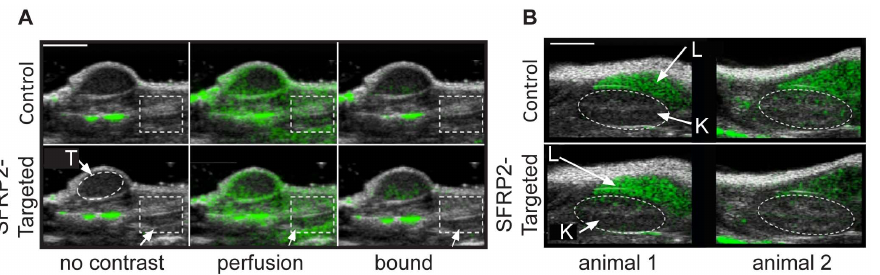
Figure 4. Modified microbubble contrast agents were not retained at significant levels in nonmalignant vasculature. B-mode images (black and white) are shown overlaid with CPS-mode images (green). CPS-mode is sensitive to ultrasound signal typically produced by microbubbles oscillating within an ultrasound field. (A) In the absence of ultrasound contrast agent (no contrast) there was no CPS-mode signal within the region of interest (dotted rectangle) outside of the tumor margins. Tissue artifacts generated the CPS-mode signal observed in the absence of contrast agent. Contrast agent freely flowing through both tumor and non-tumor vasculature generated CPS-mode signal throughout the field of view (panel A, perfusion, middle frames) with either streptavidin-coated (control, upper frames) or SFRP2- targeted ultrasound contrast agent (lower frames). No signal remained within the region of interest drawn outside of the tumor margins after allowing all freely flowing contrast agent to be cleared from the vasculature, while SFRP2 specific signal was retained within the tumor margins. (B) Modified microbubble contrast agents were not retained within kidney vasculature. Freely flowing streptavidin-loaded microbubbles (panel B, control, upper frames) or SFRP2 - targeted microbubbles (panel B, lower frames) were allowed to clear from the vasculature prior to three-dimensional molecular imaging. Single frames are shown from two different animals (animal 1 or animal 2). The dotted oval region of interest represents the location of the kidney (K) and there was no significant difference in average pixel intensity after injection of either streptavidin-loaded or SFRP2 -targeted microbubbles. In contrast, the liver (L) retained both modified microbubble contrast agents to a high degree. White scale bars in panels A and B represent 5 mm.